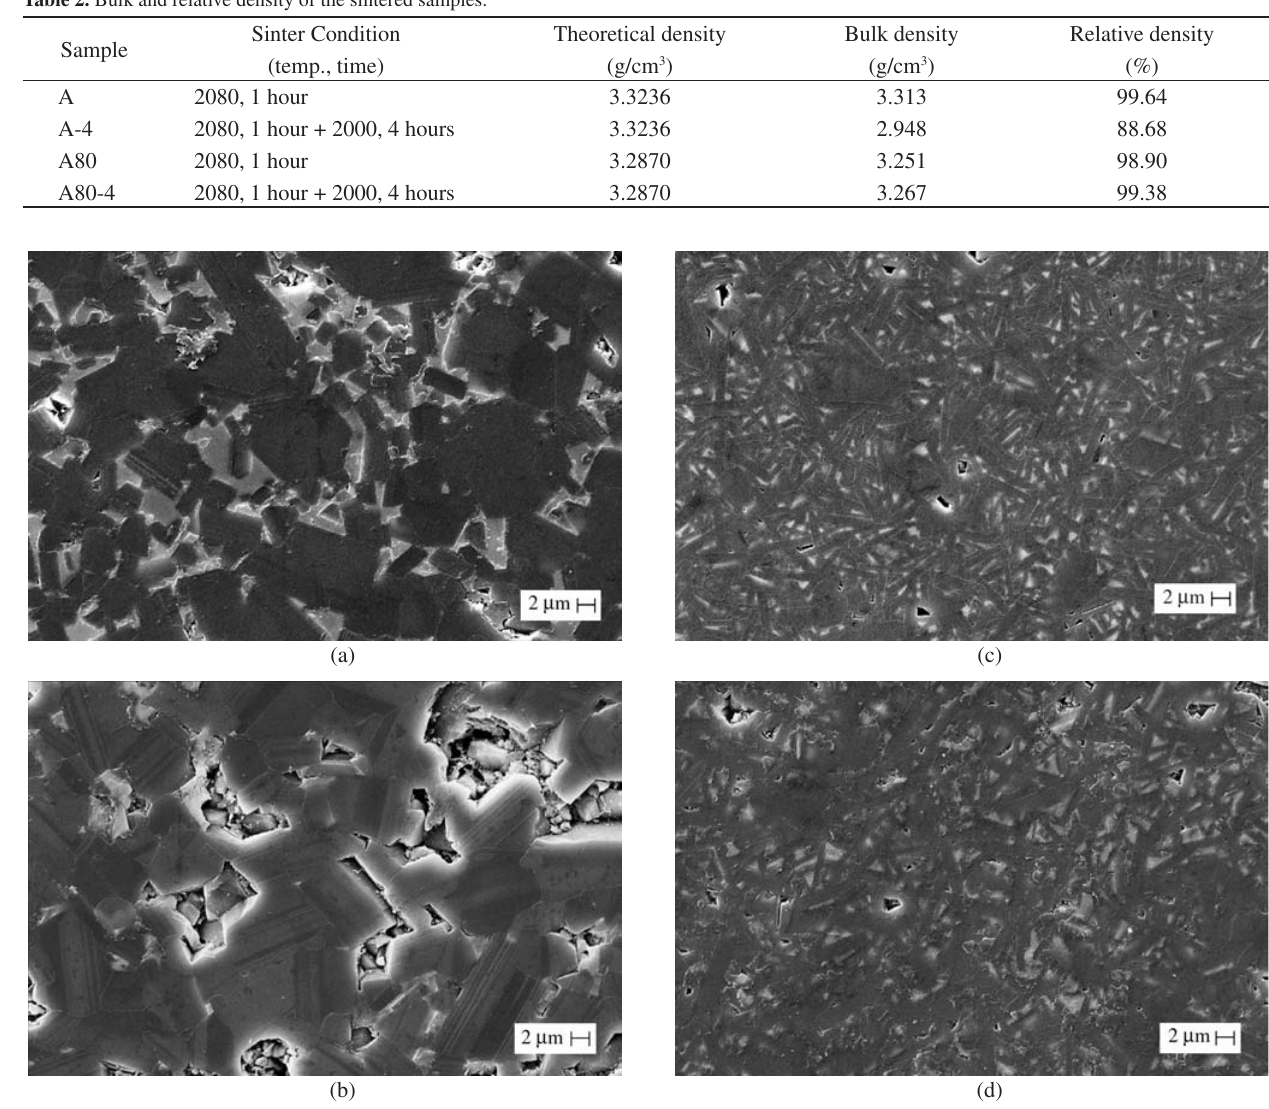
Figure 4. Microstructures of sample a) A; b) A-4; c) A80; and d) A80-4.